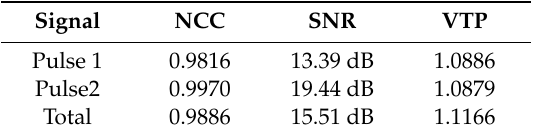
Table 3. Evaluation results of the proposed de-noising method.